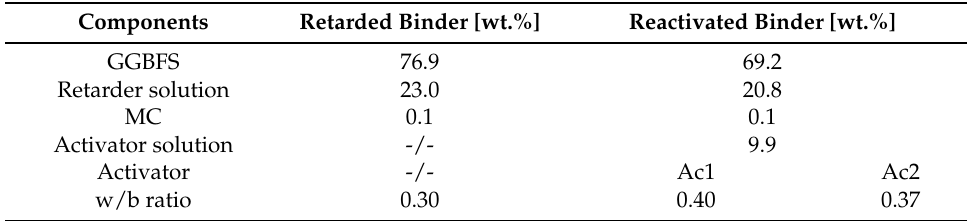
Table 1. Composition of the retarded and reactivated binder with the w/b